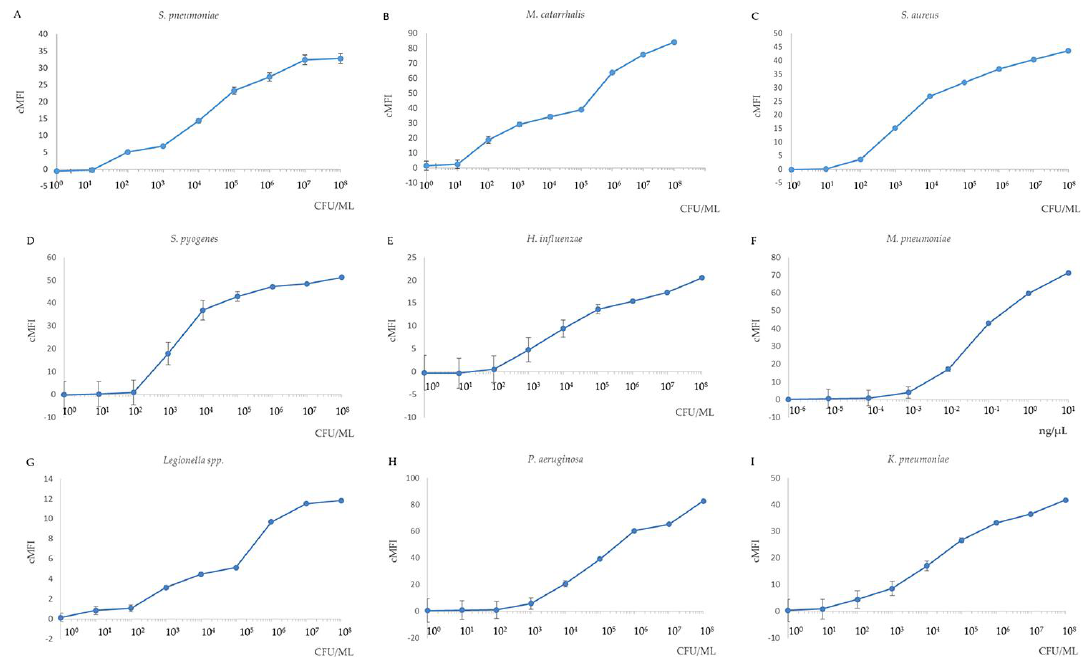
Figure 3. Sensitivity of the nine target bacteria in MPLT assay. Correlation of Ct values derived from the real-time PCR assay and different bacterial concentration. ( A ) S. pneumoniae ; ( B ) M. catarrhalis ; ( C ) S. aureus ; ( D ) S. pyogenes ; ( E ) H. influenzae ; ( F ) M. pneumoniae (DNA); ( G ) Legionella